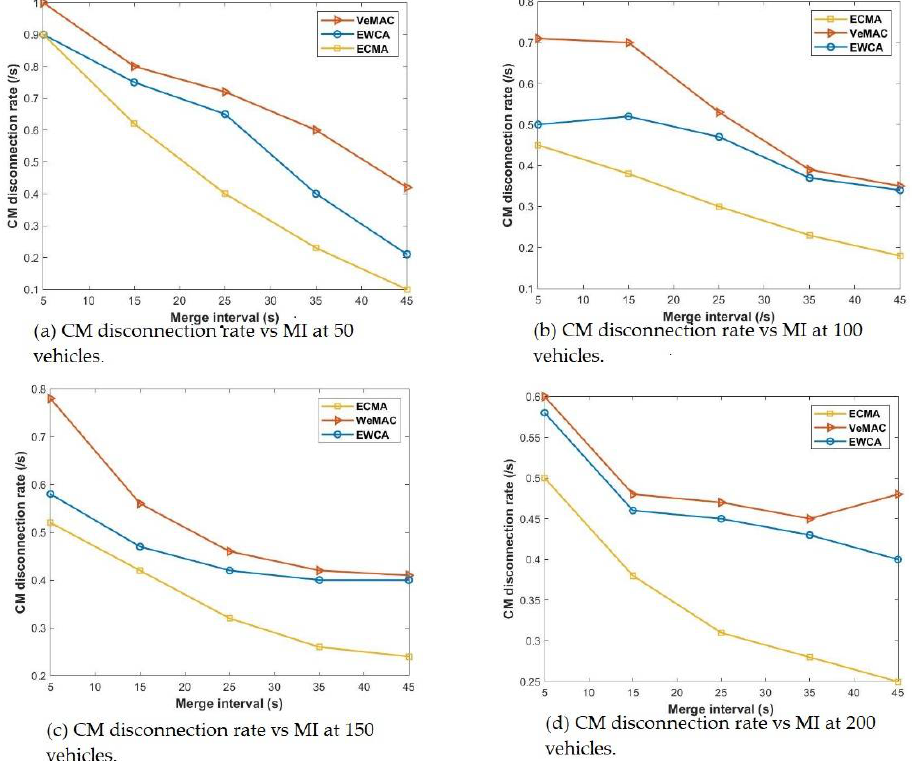
Figure 8. CM disconnection frequency and it influence on Mw.